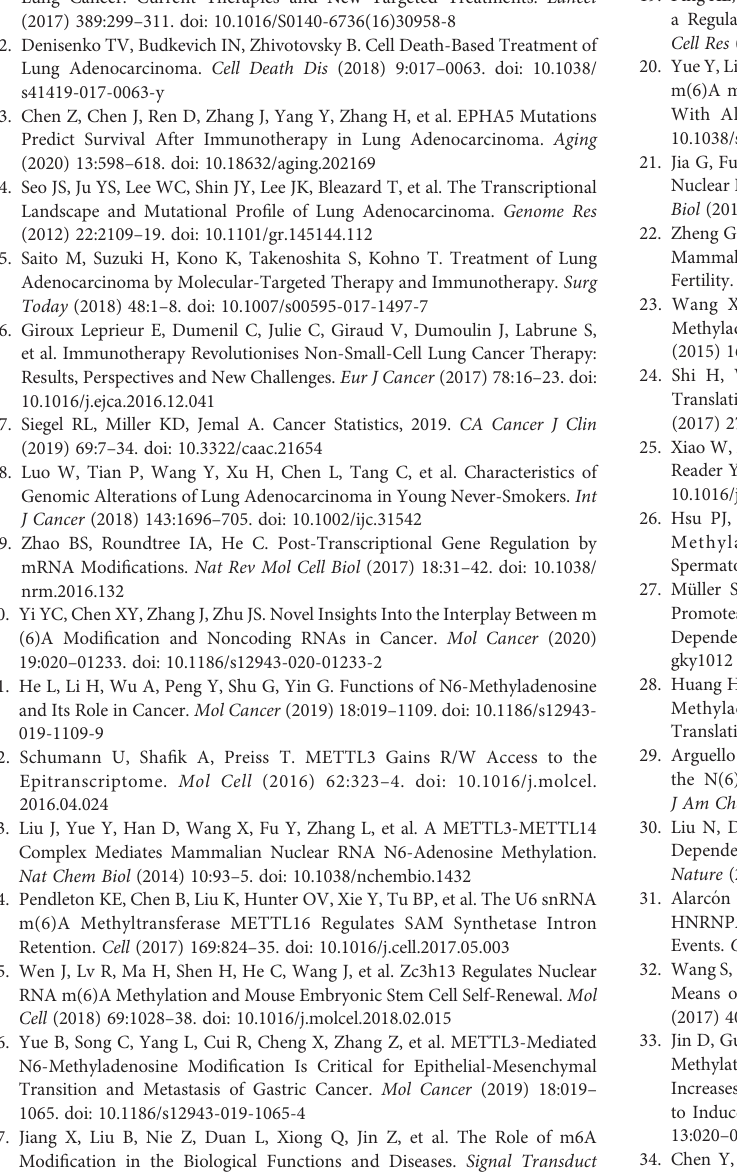
Supplementary Figure S3 | Consensus clustering of 24 m 6 A regulators in lung adenocarcinoma. (A) Consensus clustering matrix for k = 3. (B) Expression of the 24 m 6 A regulatorsin the threem 6 Aclusters. Theupper and lowerends ofthe boxes representedinterquartile rangeofvalues. Thelines inthe boxesrepresentedmedian value, and black dots showed outliers. The asterisks represented the statistical p value (*P< 0.05; **P< 0.01; ***P< 0.001). (C, D ) Heatmap showing the biological processes in different m 6 A modi fi cation patterns obtained by GSVA enrichment analysis. Red shows activated pathways and blue shows inhibited pathways. B m 6 A cluster A vs m 6 A cluster C; C m 6 A cluster B vs m 6 A cluster C. (E) GO enrichment analysis of the 73 m 6 A phenotype-related DEGs.